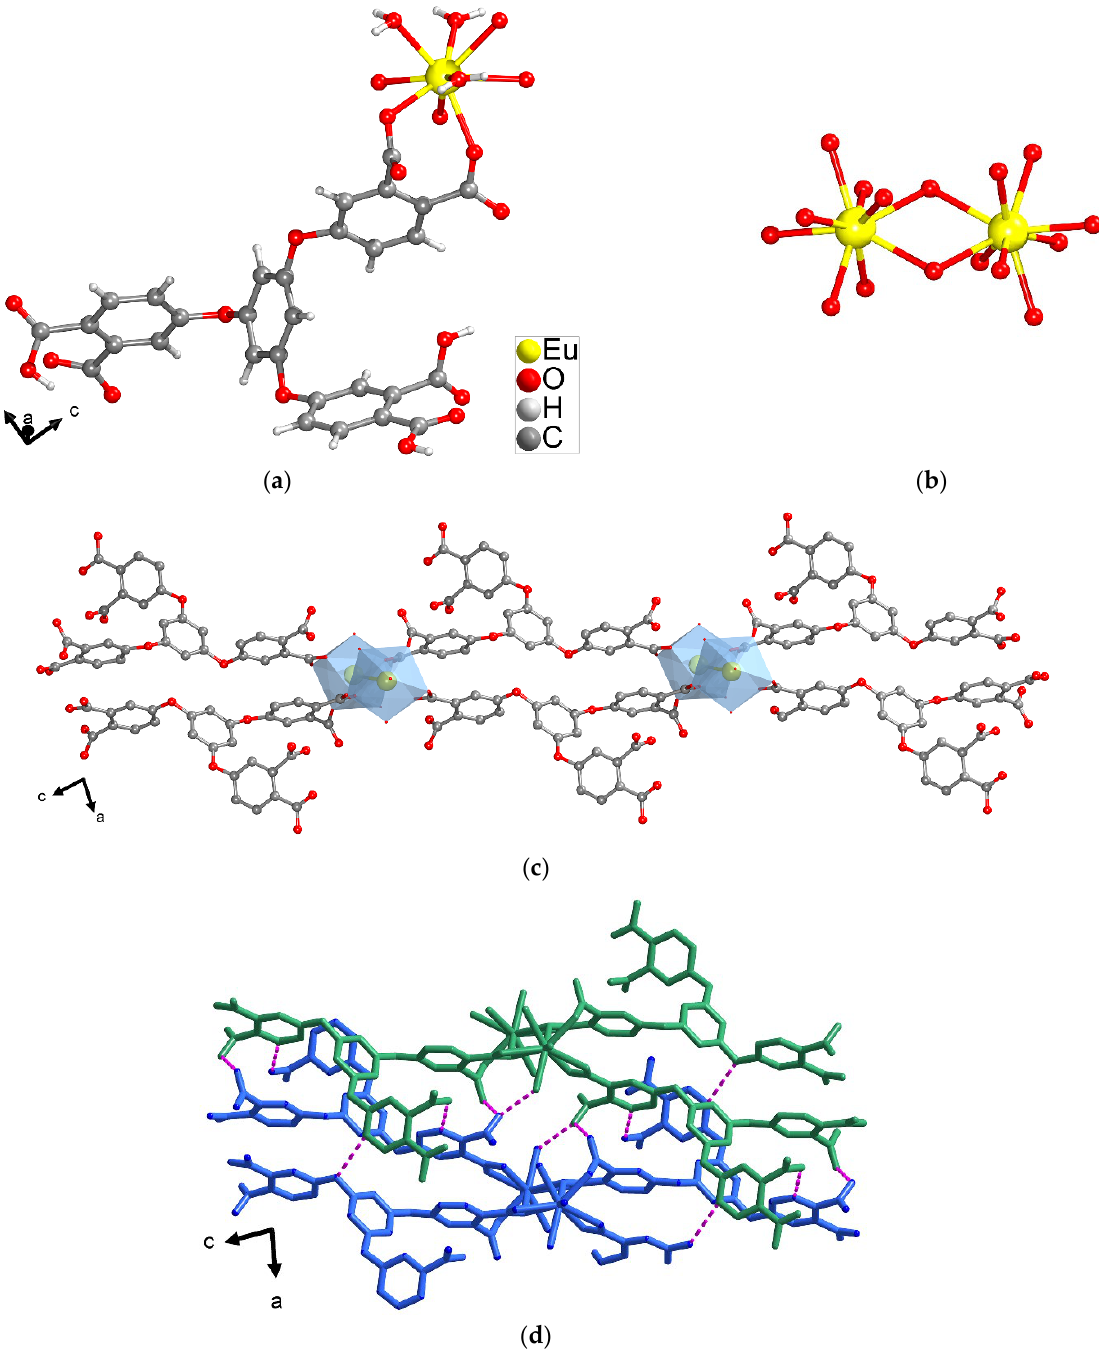
Figure 2. X-ray crystal structure of the compound 2 : ( a ) elementary unit of the coordination polymer; ( b ) binuclear secondary building unit; ( c ) linear chain of the coordination polymer; ( d ) supramolecular interactions between the chains (two separate chains are colored blue and